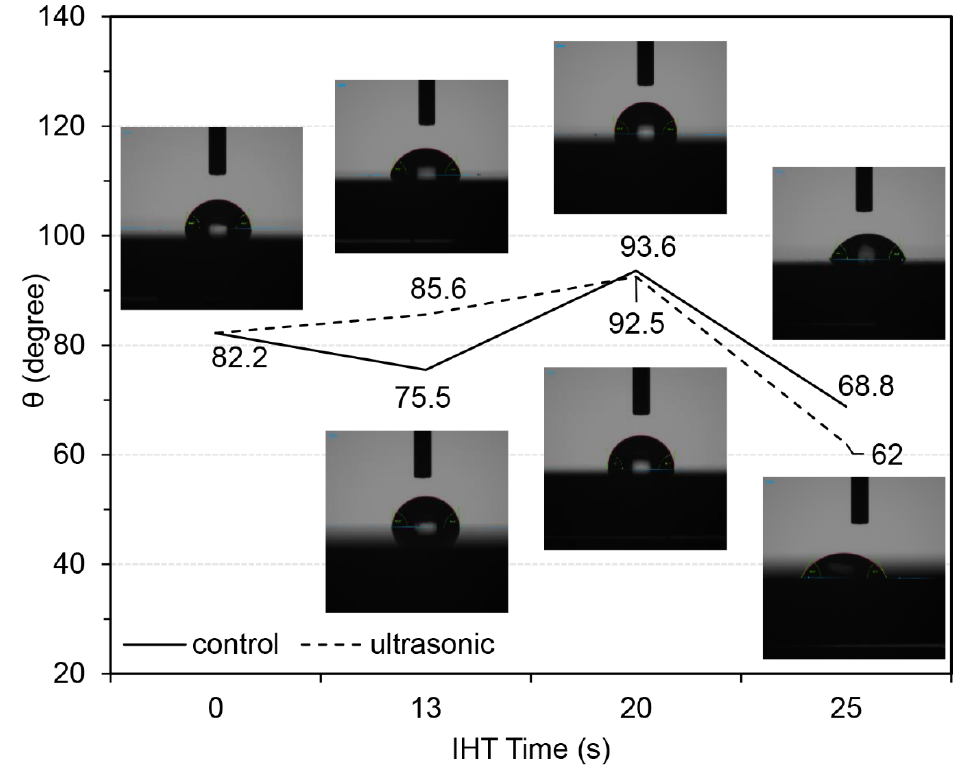
Figure 7. The water droplet on the titanium surface and the contact angles before and after IHT with and without ultrasonic assistance for 13–25 s.